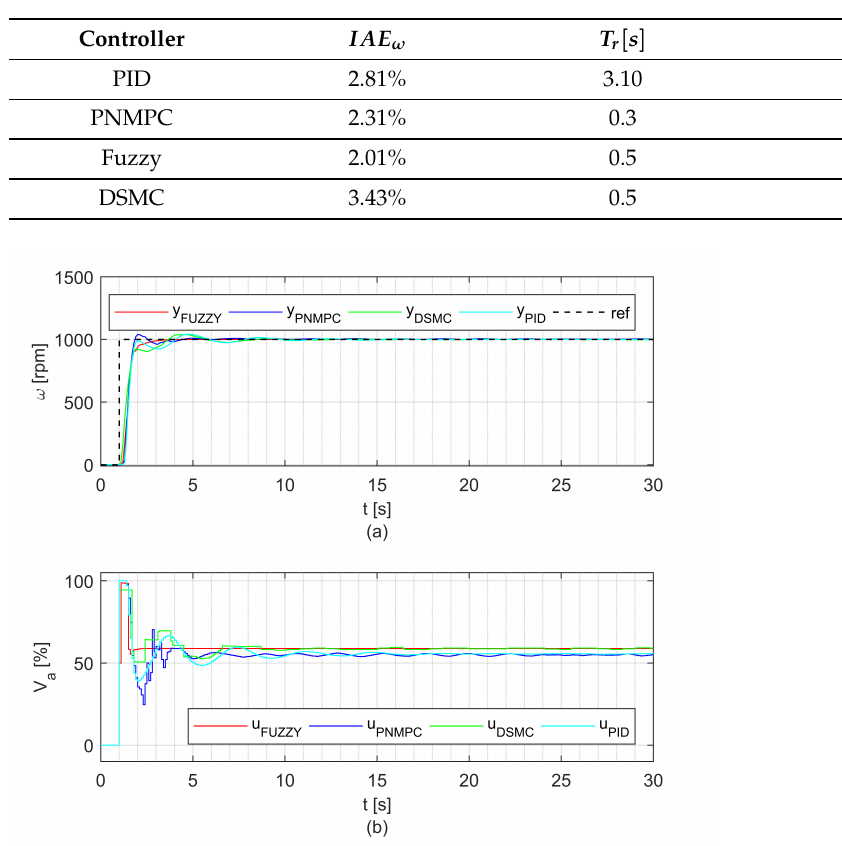
Table 7. Speed signal of the analyzed controllers considering the application of step signal.